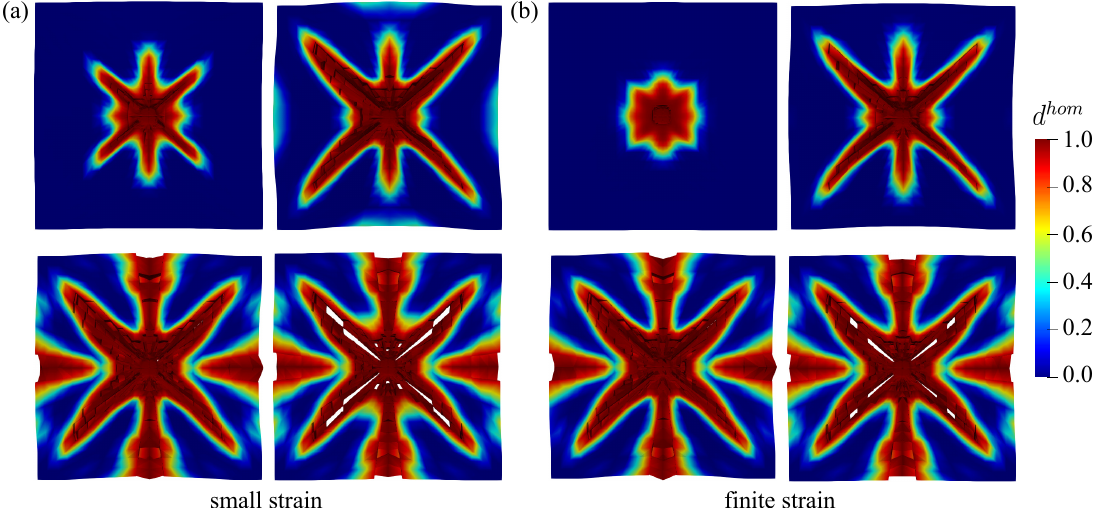
Figure 16. Bottom view of damage evolution for thick plate impact test: ( a ) small strain and ( b ) finite strain